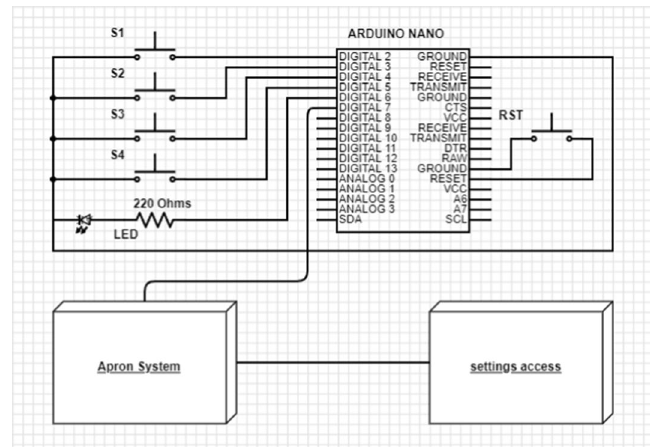
Fig. 12 Circuit diagram of 4 pin security system designed in schematic diagram maker circuit diagram of GPS module connecting to Raspberry